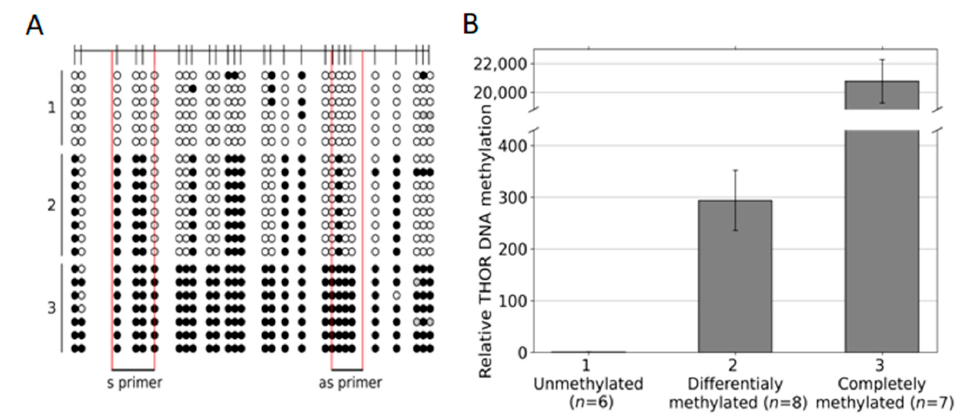
Figure 4. THOR Idiolocal Normalized Methylation-Specific PCR (IDLN-MSPCR) on hypomethyl- ated, partially methylated, and full methylated THOR sequences. Six plasmid preparations with hypomethylated, eight with partially methylated, and seven with dense methylated THOR se- quences ( A ) were measured by IDLN-MSPCR with the indicated primers (S1/AS1 TAPS) covering four CpG positions, each to define their relative DNA methylation status ( B ).